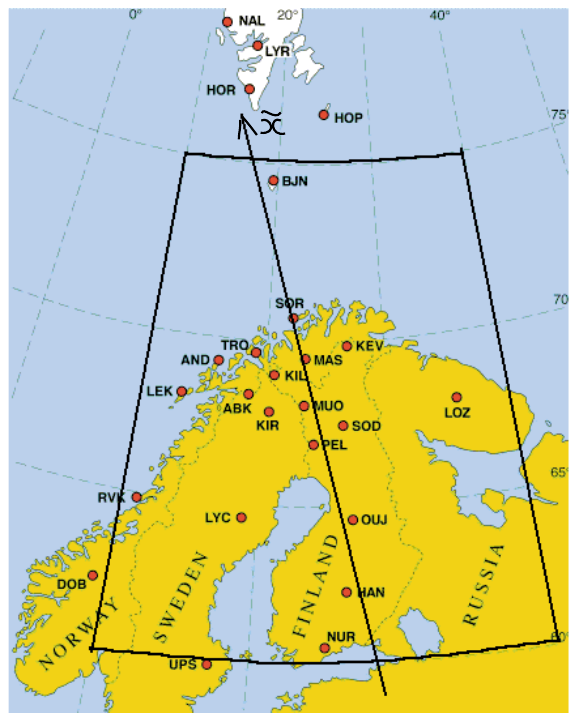
Fig. 1. IMAGE magnetometer stations in 2000. The boundaries of the grid area for the vortex locations, and the central geomagnetic meridian are also